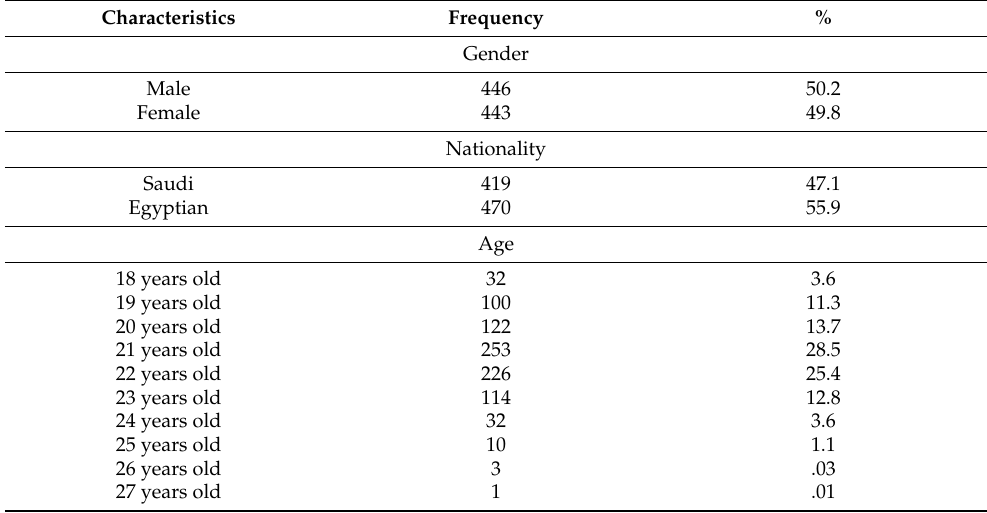
Table 1. Sociodemographic characteristics of the students.